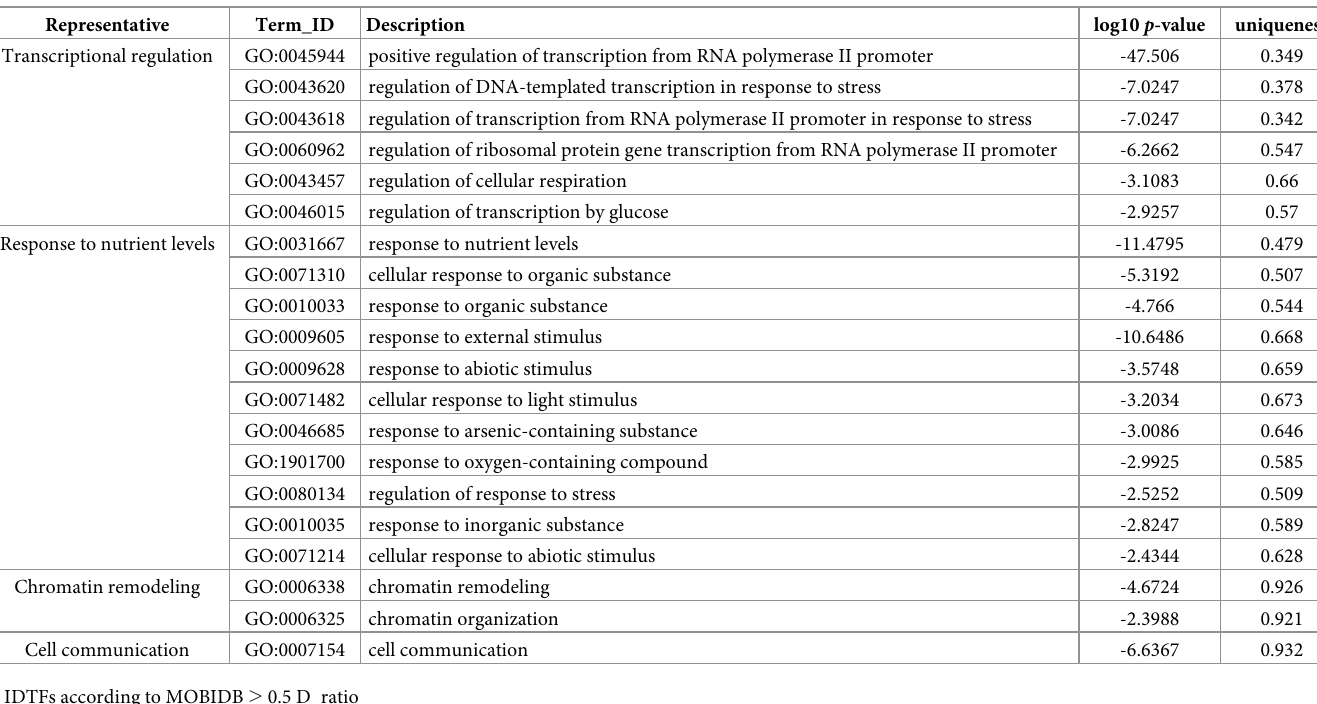
Table 1. GO clustering of IDTFs a,b . Representative